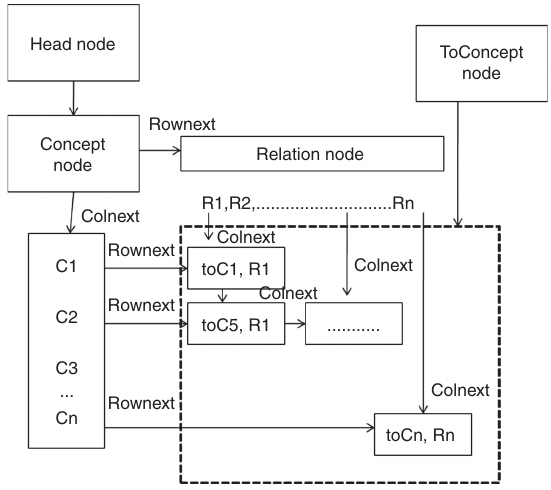
Figure 3. Representation of UNL Graph in a Multi-List Data